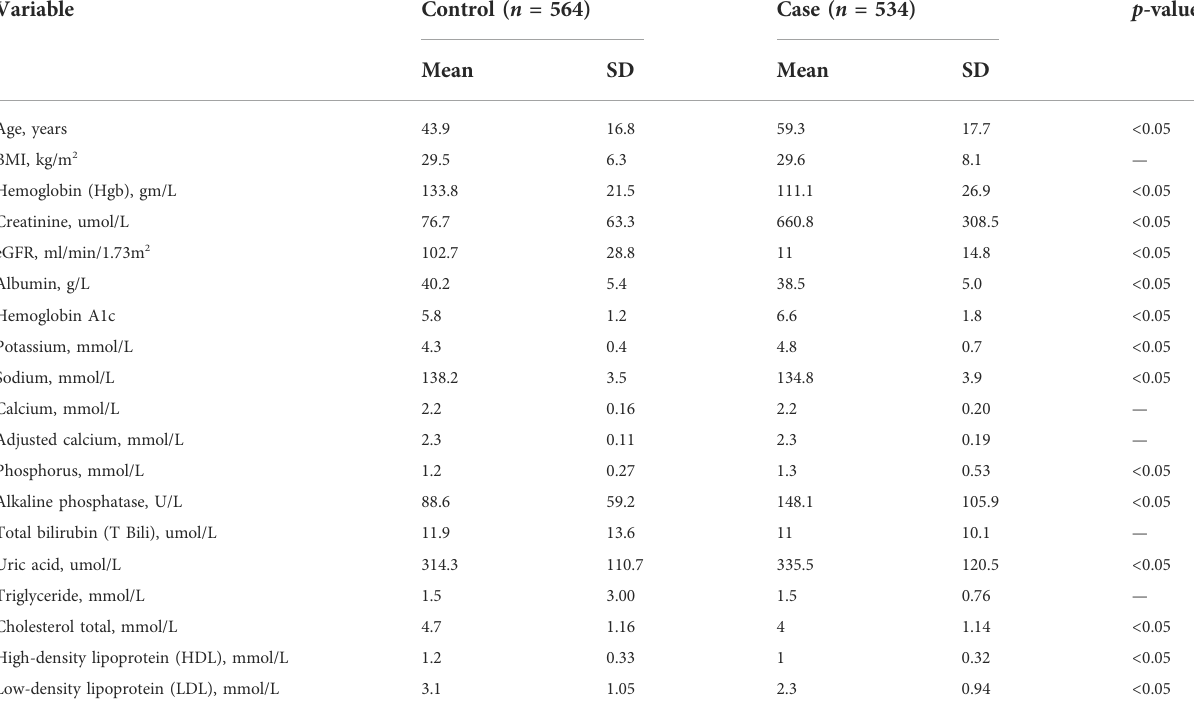
TABLE 1 Baseline characteristics of the